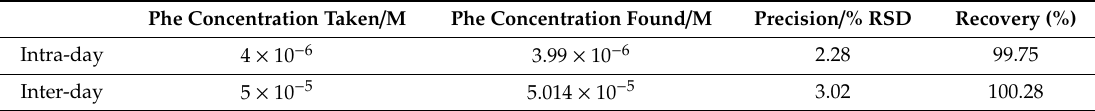
Table 4. The results of studies on the accuracy of the electroanalytical method. Phe Concentration Taken /